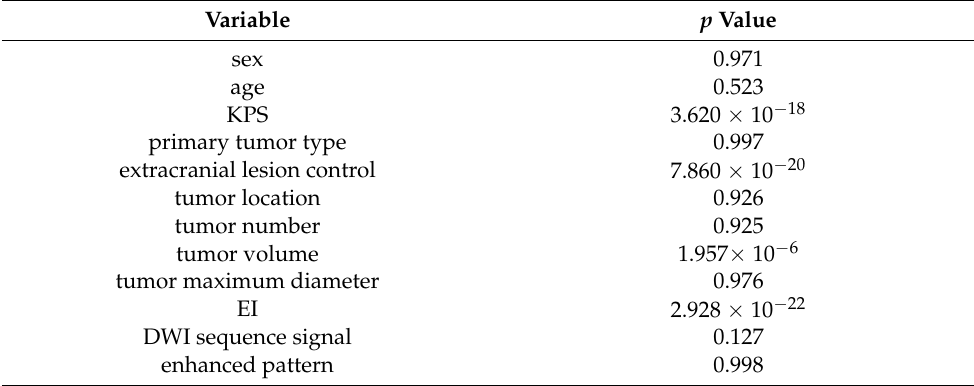
Table 2. Univariate analysis of patient characteristics.